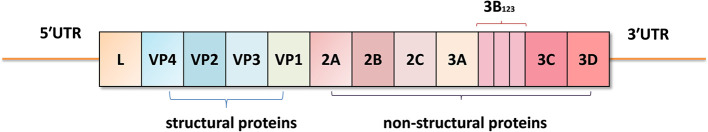
The viral genome structure of foot-and-mouth disease virus (FMDV). The viral genome contains a 5′-untranslated region (5′UTR), a large open reading frame (ORF) including the L, VP4, VP2, VP3, VP1, 2A, 2B, 2C, 3A, 3B(3B1, 3B2, and 3B3), 3C, and 3D coding regions, and a 3′UTR.